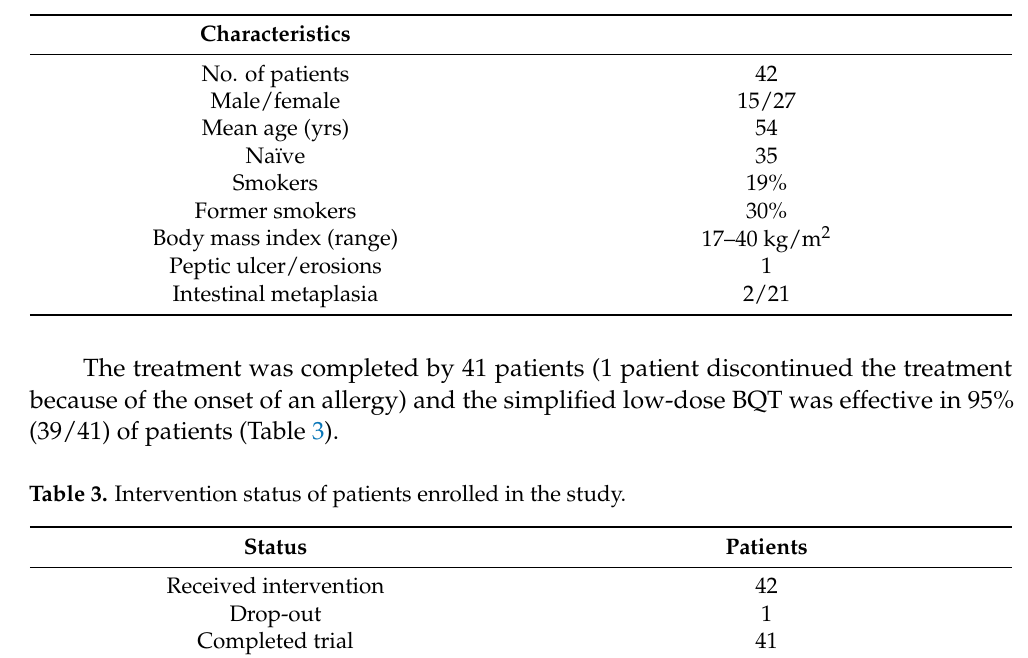
Table 2. Baseline characteristics of treated patients.